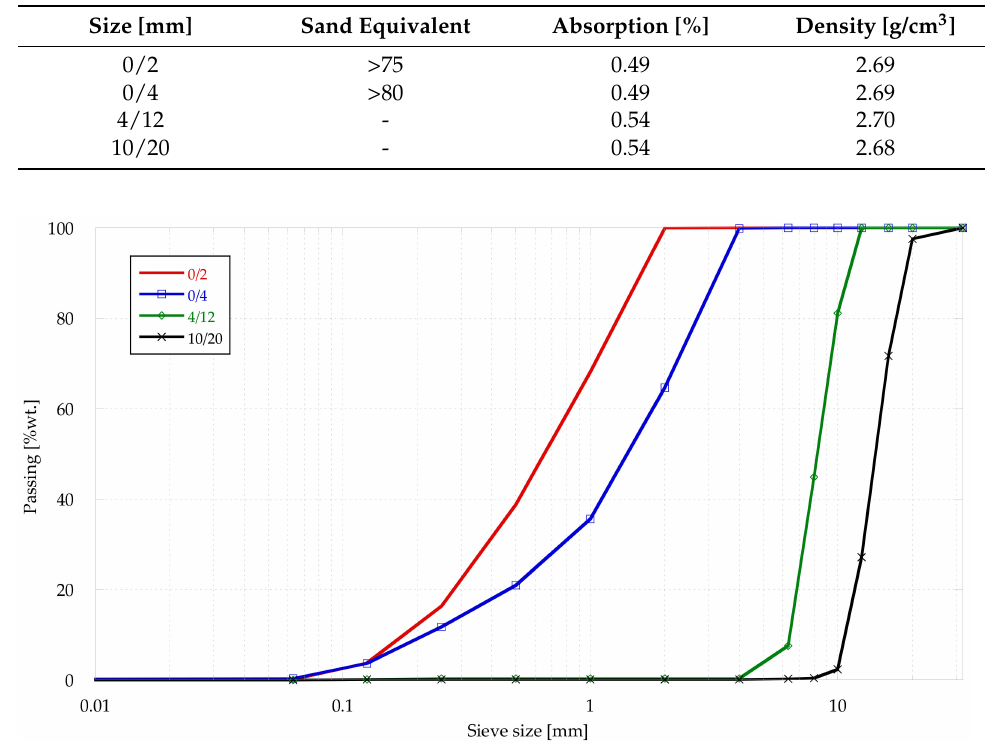
Table 1. Aggregate physical properties.